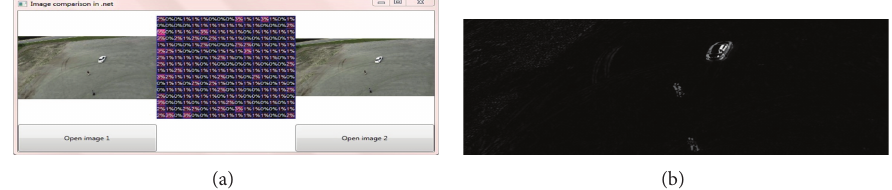
Figure 7: (a) Difference pixel structure of 𝐹𝐷 𝑟 (𝑚, 𝑛,𝑡) using (2). (b) Difference image, 𝐹𝐷 𝑟 (𝑚,𝑛,𝑡) using (21).